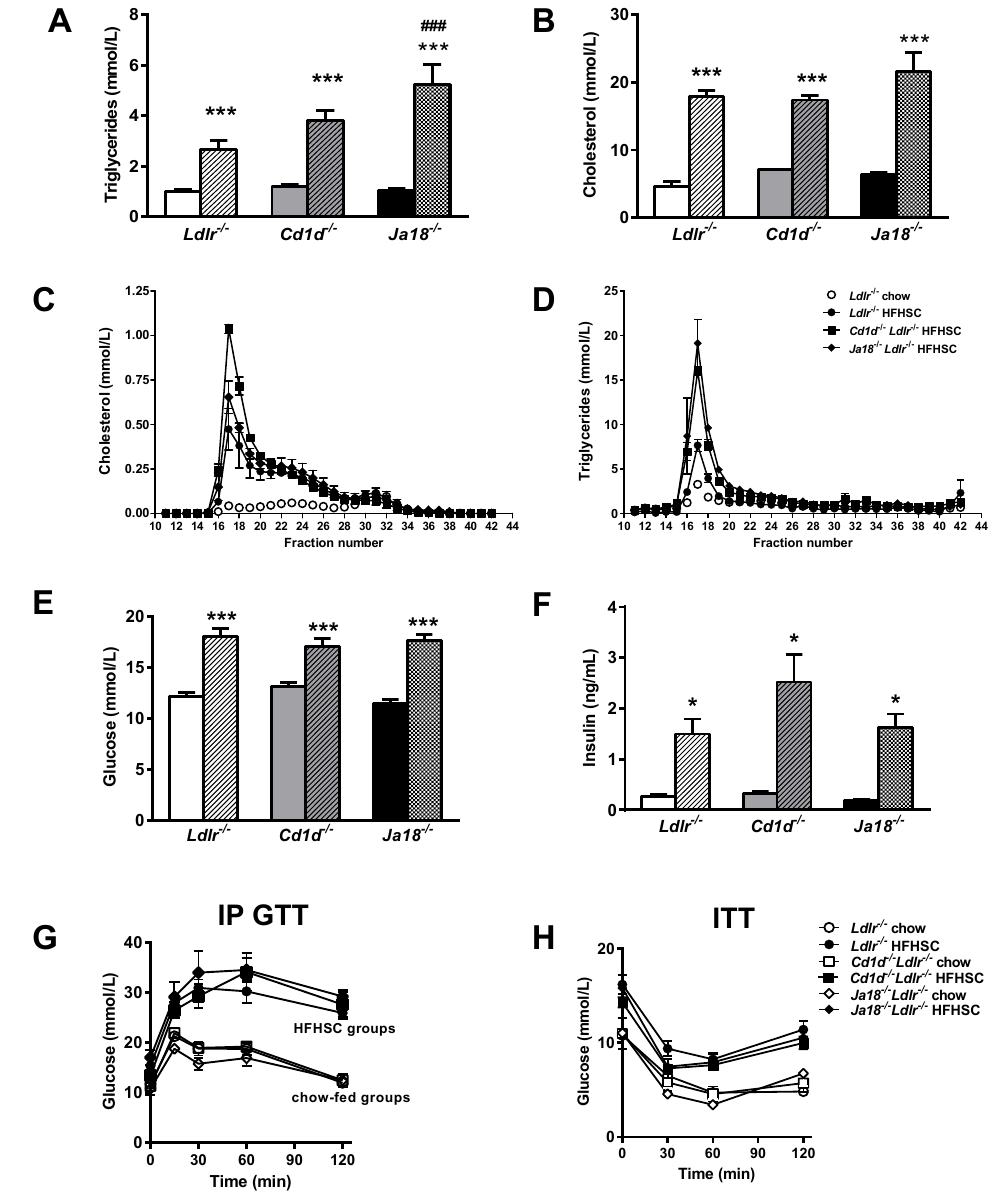
Figure 2. Effects of NKT cell deficiency on metabolic abnormalities that accompany obesity. ( A ) Plasma triglyceride and ( B ) cholesterol levels in mice fed chow or HFHSC diets. Plasma lipoprotein cholesterol ( C ) and triglyceride ( D ) distribution in lean Ldlr − / − and HFHSC-fed Ja18 − / − Ldlr − / − , Cd1d − / − Ldlr − / − , and Ldlr − / − mice. ( E ) Plasma fasting glucose, ( F ) fasting insulin, and ( G ) intraperitoneal (ip) glucose tolerance test. ( H ) Insulin tolerance test. n = 10 per group. * p < 0.05 vs. corresponding lean mice, *** p < 0.001 vs. corresponding lean mice, ### p < 0.0001 vs. HFHSC-fed Ldlr − / − mice. Open symbols and solid bars—chow-fed animals; closed symbols and hatched bars—HFHSC-fed animals.